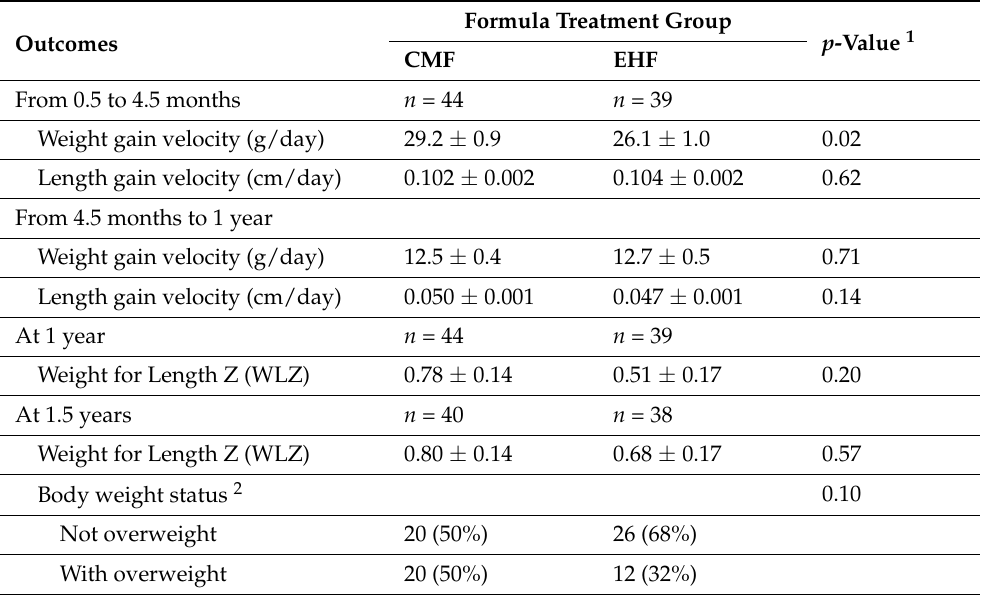
Table 2. Anthropometric outcomes by randomized infant formula treatment group of children who completed trial at 1